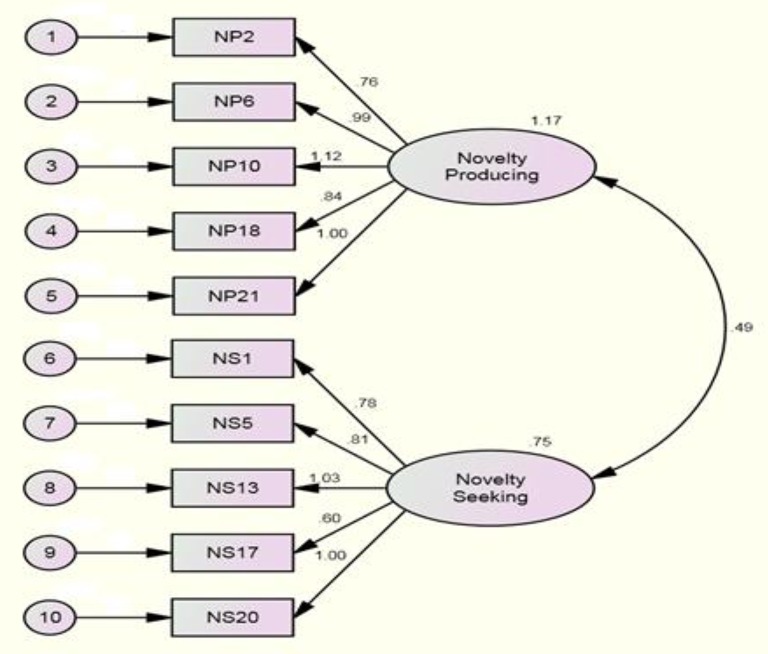
The Two factor path diagram for Model 2.